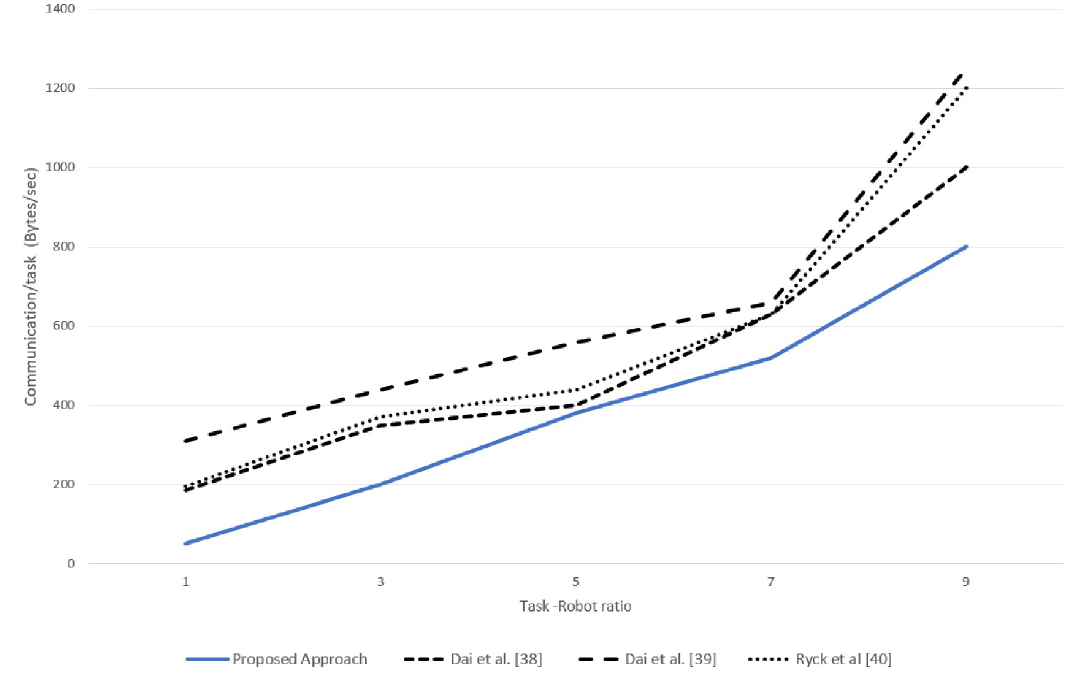
Fig 16. Real experimentation results for average communication overhead per task for various task-robot